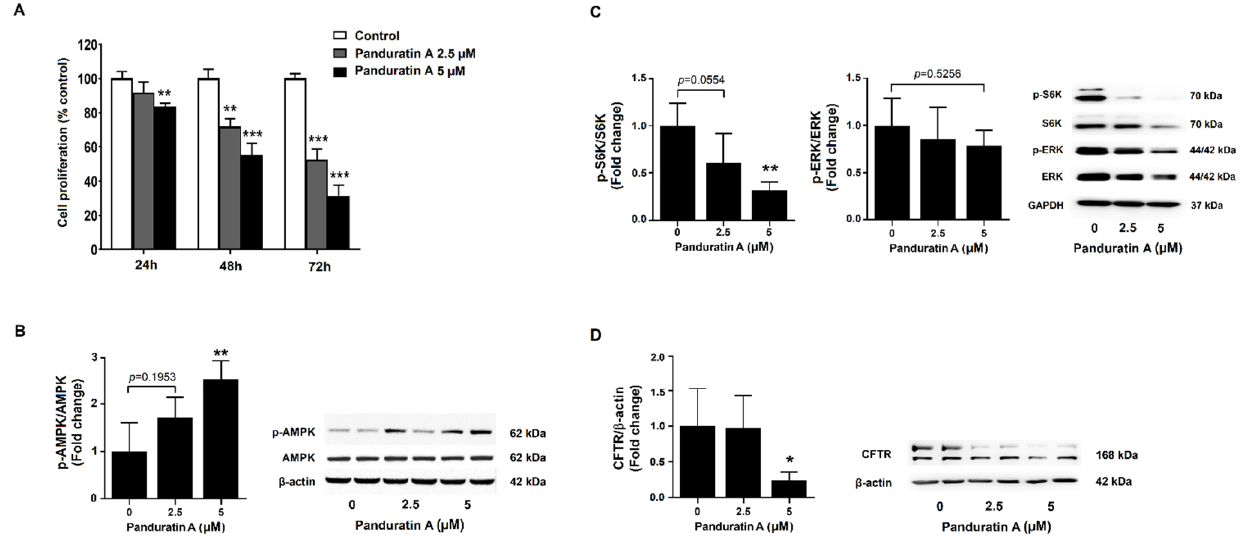
Figure 4. Effect of panduratin A on cell proliferation in ADPKD cells. ( A ) Cell proliferation was examined after 24, 48, and 72 h of incubation ( n = 3). ( B – D ) Representative immunoblots and quantitative protein expressions following treatment of cells with panduratin A at indicated concentrations for 24 h ( n = 5). Data are shown as mean ± SD. * p < 0.05, ** p < 0.01, and *** p < 0.001 compared to control.